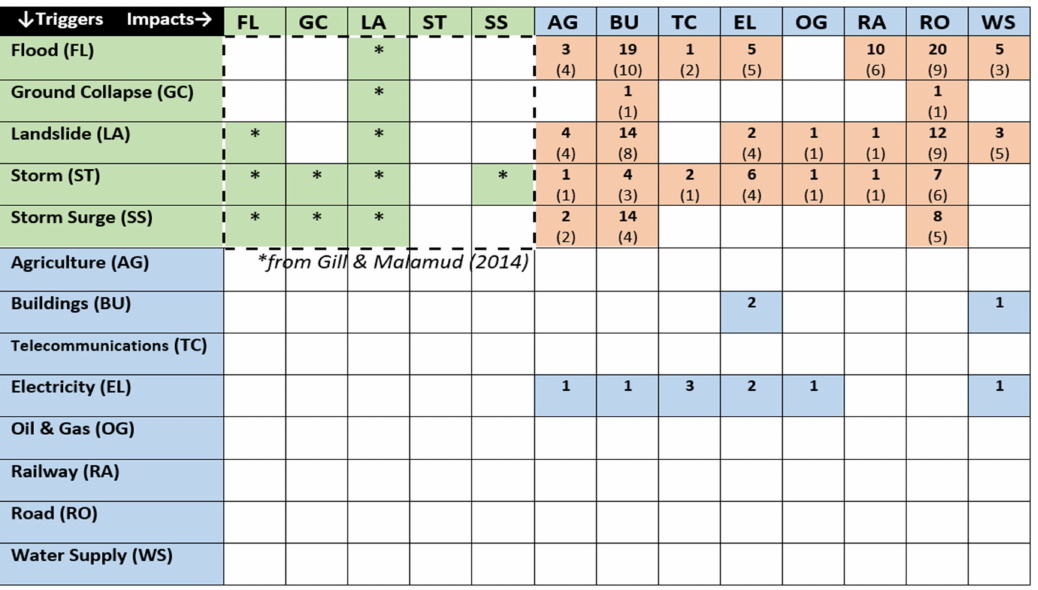
Figure 5. Matrix of triggers and impacts showing the number of cases in bold and the number of mechanisms in